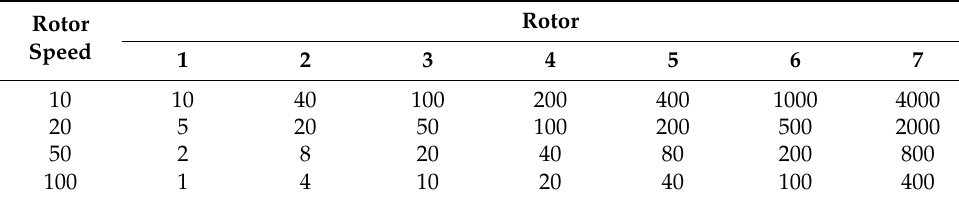
Table 7. Coefficients of